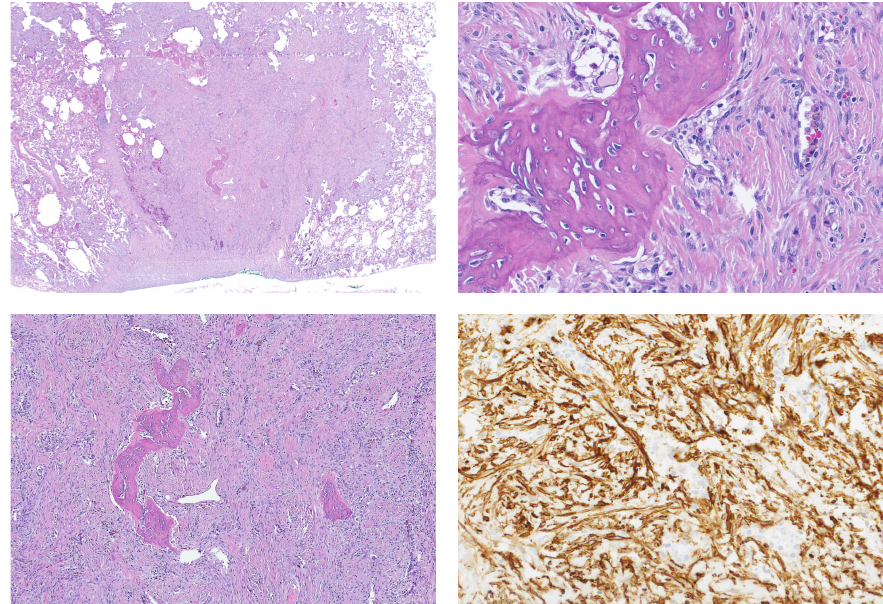
Figure 5: Fibromuscular tissue growth with nonneoplastic ossification; immunohistochemistry nodules composed of cells, vimentin, AML, calponin, ALK1, a240, D, and Ki67 20%. AML: actina de m´usculo liso (smooth muscle actin).